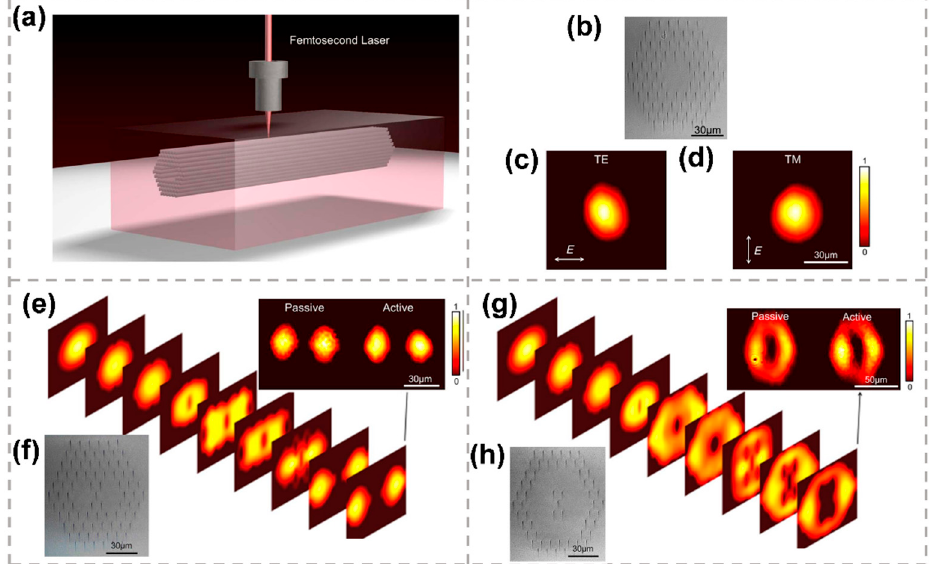
Figure 4. ( a ) The fabrication schematic plots of a typical photonic microstructure with a guiding core surrounded by a hexagonal track array. ( b ) Microscopic image of the cross section of the femtosecond laser written photonic fundamental mode waveguide in Nd:YAG crystal. Measured near-field modal profiles along both TE ( c ) and TM ( d ) polarizations at 1064 nm. ( e ) Beam profile evolution as the 1064 nm light propagates along the splitter waveguide structure. ( f ) Microscopic pictures of splitter waveguide structure. ( g ) beam profile evolution as the 1064 nm light propagates along the ring-shaped photonic structure. ( h ) Microscopic pictures of the ring-shaped photonic structure [70]. Reproduced from [70] with permission of the Springer Nature, 2022.